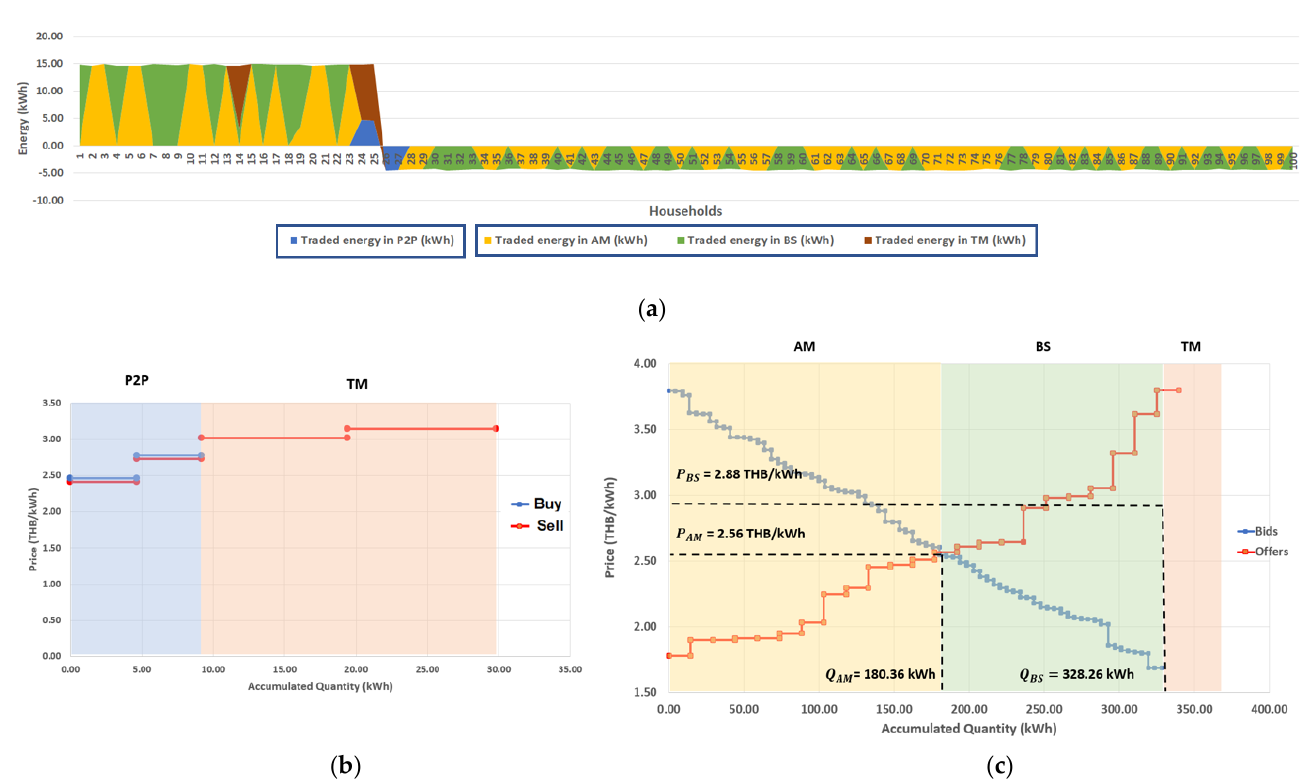
Figure 7. ( a ) Energy allocation in decentralized trading model. ( b ) Fully-P2P trading option. ( c ) Community-based trading option.